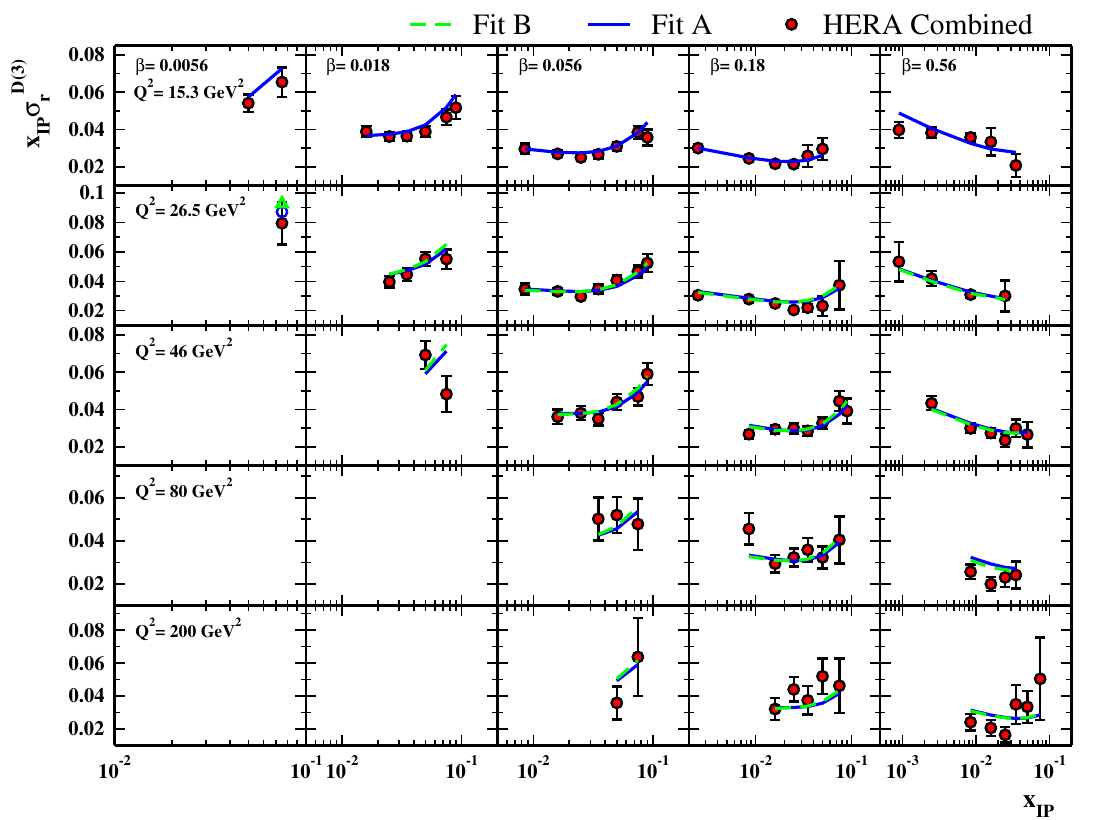
Fig. 7 A comparison between the results of Fit A and Fit B and the HERA combined reduced diffractive cross section x IP σ D a function of x IP for different values of β and Q 2 . The verticalerror bars indicate the statistical, systematic and procedural uncertainties added in